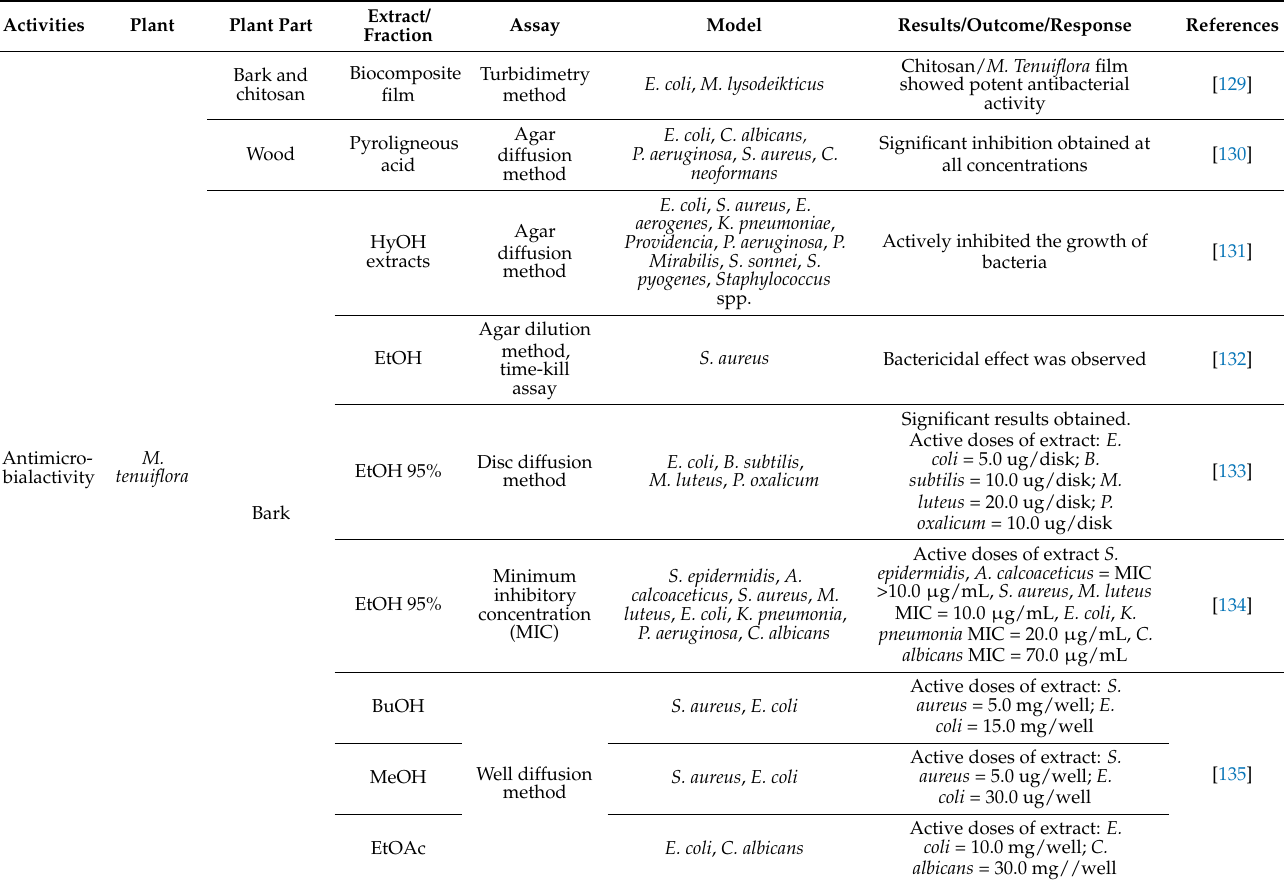
Table 2. Pharmacological studies of different species of the genus Mimosa